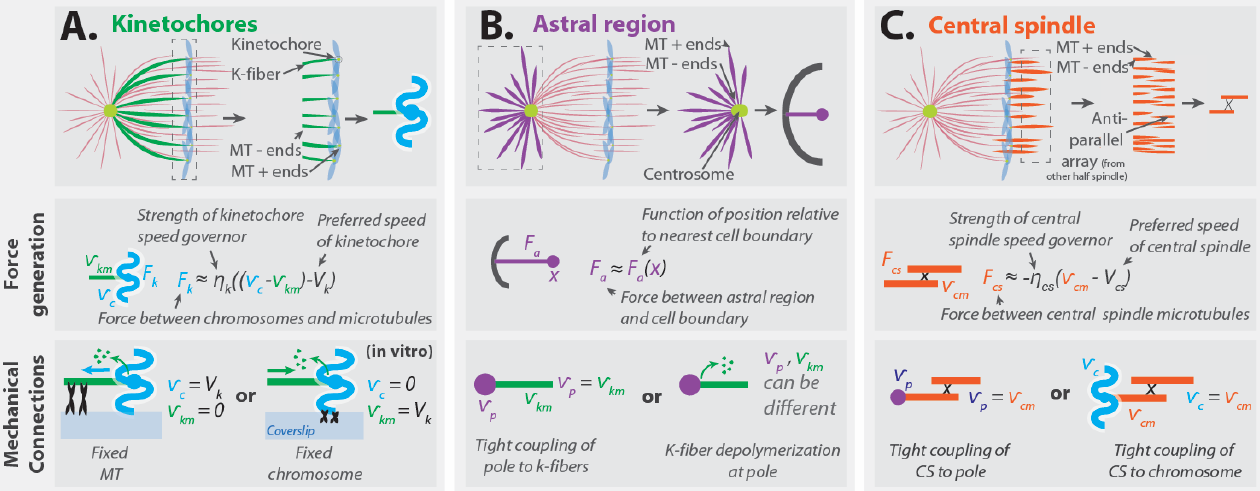
Figure 4. ( A , top) A coarse-grained mechanical model of kinetochore forces and K-fibers, which are bundles composed of kinetochore microtubules. ( A , middle) Kinetochores apply forces between chromosomes and kinetochore microtubules, 𝐹 𝑘 . This force depends on the extent to which the relative velocity of chromosomes, 𝑣 𝑐 , and kinetochore microtubules, 𝑣 𝑘𝑚 , differs from the kinetochore’s preferred speed, 𝑉 𝑘 . ( A , bottom) In vitro movement of the microtubules and chromosomes is dependent on which mechanical linkages are present. ( B , top) A coarse-grained mechanical model of the astral region forces. ( B , middle) The astral region applies forces between the pole and the cell boundary, 𝐹 𝑎 . This force depends on the distance between the pole and the cell boundary, 𝑥 . ( B , bottom) Two different possible couplings with implications for the relationship between the velocity of kinetochore microtubules, 𝑣 𝑘𝑚 , and the velocity of spindle poles, 𝑣 𝑝 . ( C , top) A coarse-grained mechanical model of central spindle forces. ( C , middle) The central spindle applies a force between the central spindle microtubules, 𝐹 𝑐𝑠 . This force depends on the extent to which the velocity of the central spindle microtubules, 𝑣 𝑐𝑚 , differs from the central spindle’s preferred speed, 𝑉 𝑐𝑠 . ( C , bottom) Two different possible couplings of central spindle microtubules: either tightly coupled to chromosomes or tightly coupled to poles.